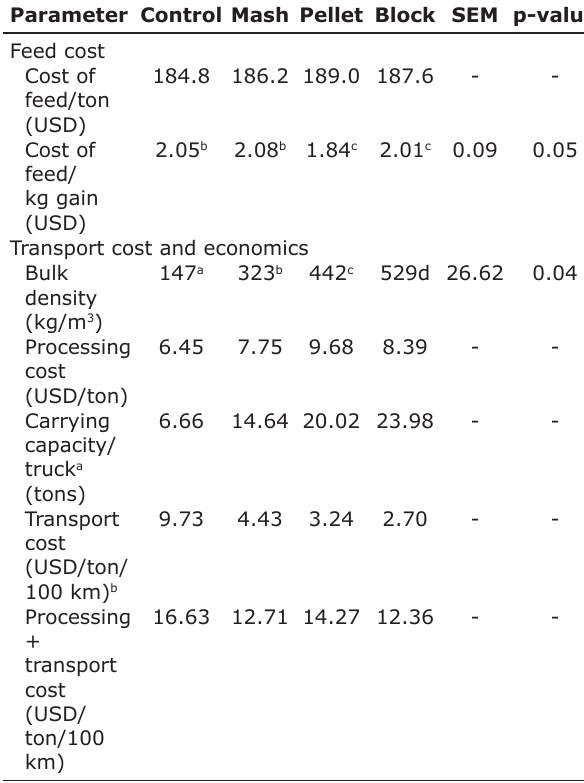
Table-5: Effect of processing on feed transport and cost